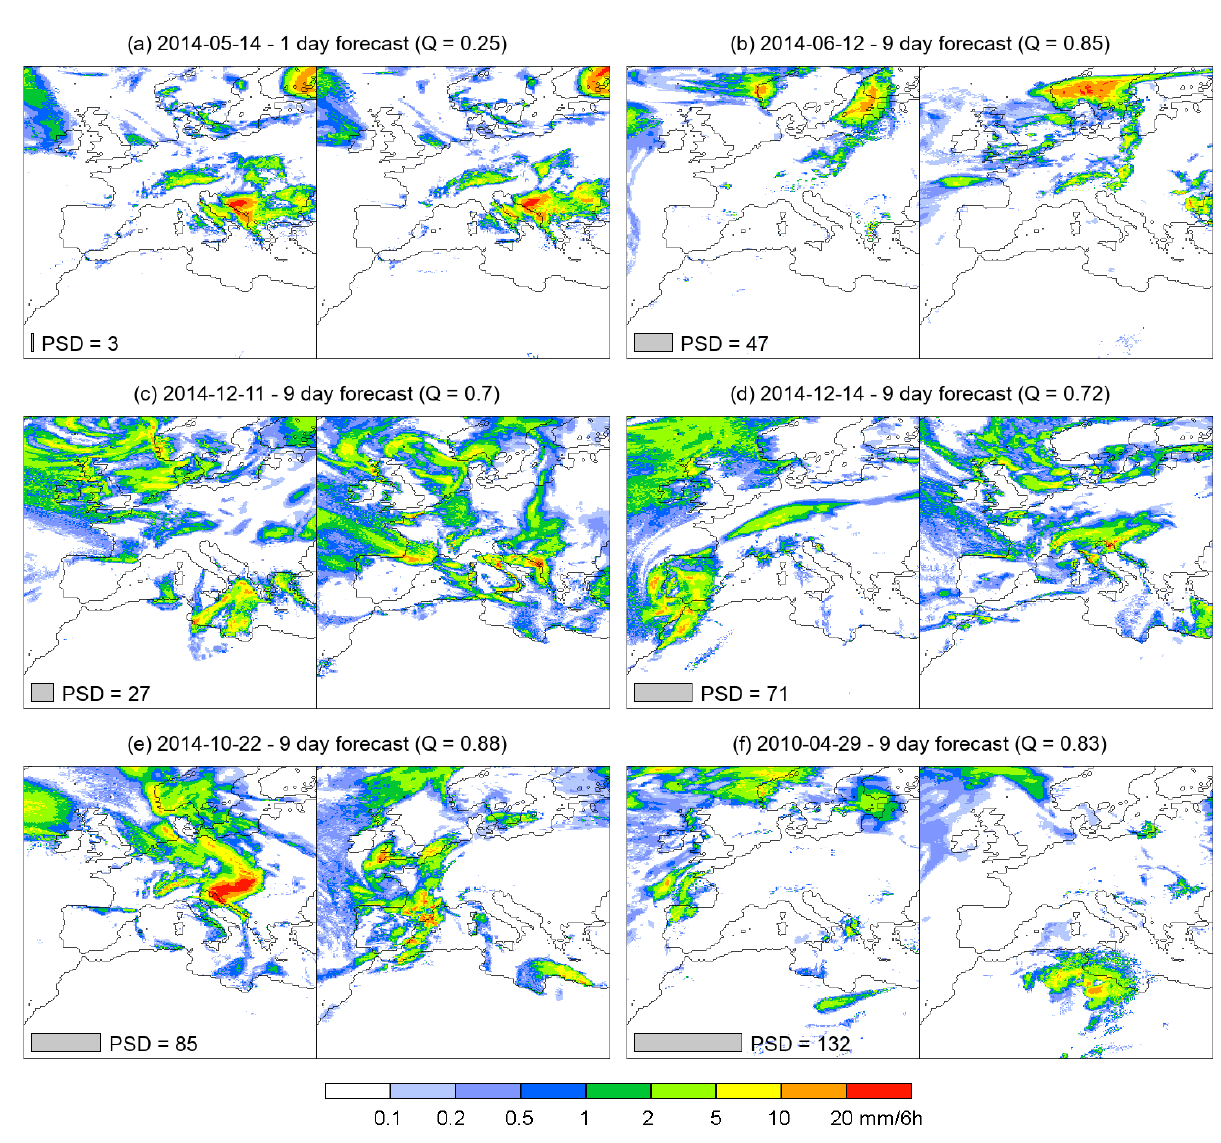
Figure 6. PSD for selected examples of 6-hourly operational ECMWF precipitation forecasts over Europe and North Africa. The domain size is 360 × 360 grid points. The left panel of each figure shows the analysis precipitation, while the right panel shows the forecast for the same 6-h period. The gray bar in the lower-left corner represents the estimate of displacement provided by PSD. The value of the Q parameter is also provided in each panel